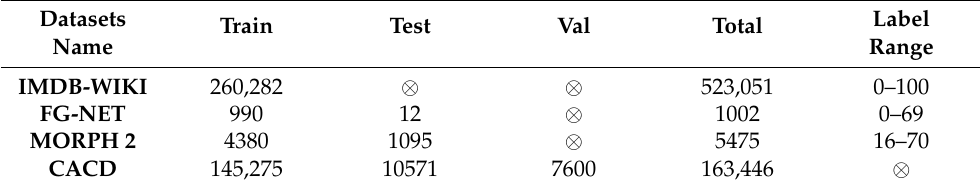
Table 3. Facial-age datasets used to evaluate the proposed